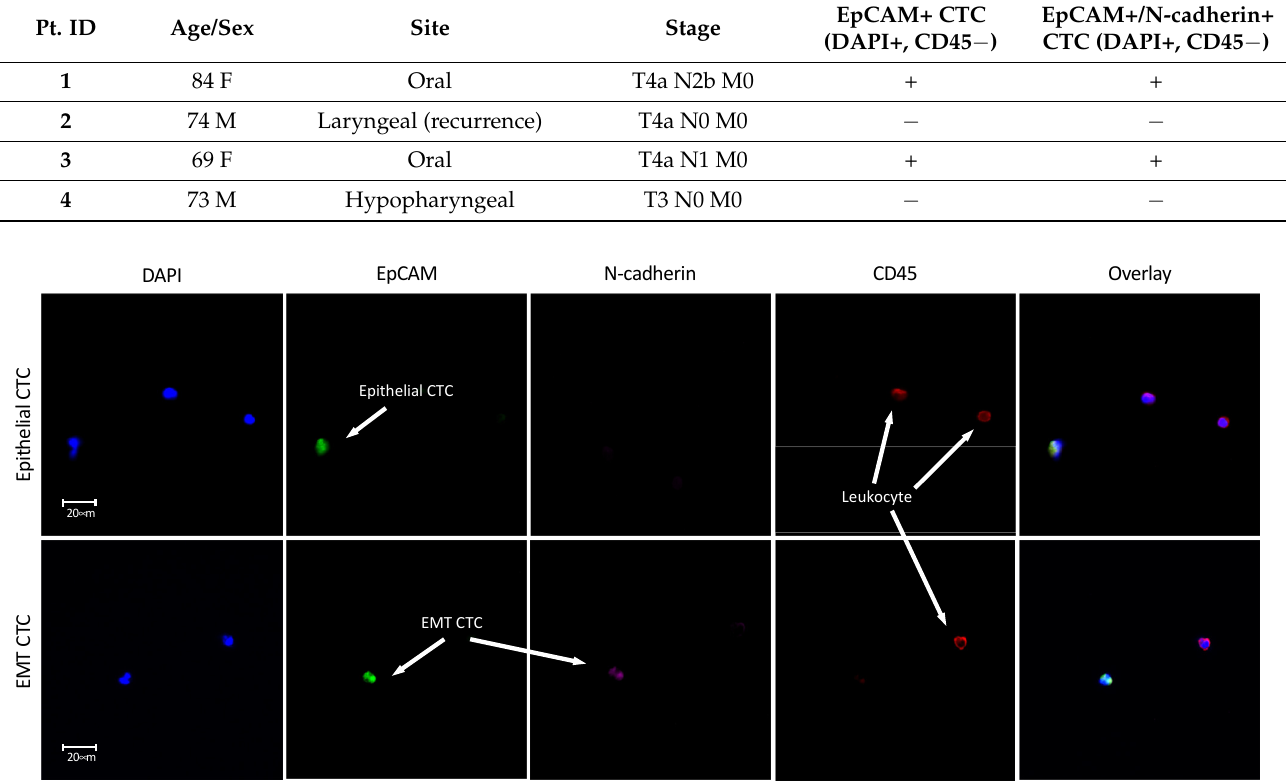
Figure 6. Immunofluorescent images from patient no. 1 demonstrating different CTC phenotypes. Images obtained on a Leica DM6000B microscope at 40× magnification. Top row-an EpCAM+ CD45 − (DAPI+) epithelial CTC is labelled next to two EpCAM- CD45+ leukocytes. Bottom row–a CD45- EpCAM+ cell also with low expression of N-cadherin, indicating the process of a transition from an epithelial to mesenchymal (EMT) phenotype.